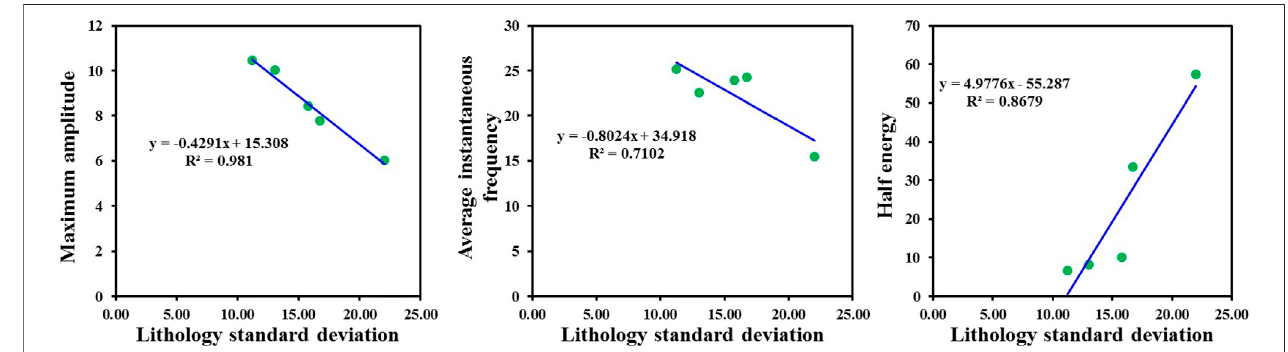
FIGURE 5 | Correlation analysis between seismic attributes and lithology standard deviation.